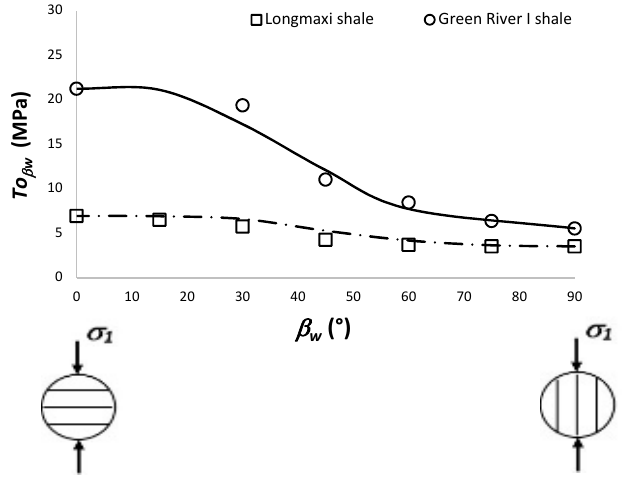
Figure 8 . Variation of the Brazilian test strengths with β w . The angle β w in the Brazilian tests is defined as the angle between the normal to the weakness plane and the direction of the maximum principal stress ( σ 1 ). The symbols represent the experimental data (Green river I shale [37] and Longmaxi shale [22]). The lines represent the Nova and Zaninetti criterion.